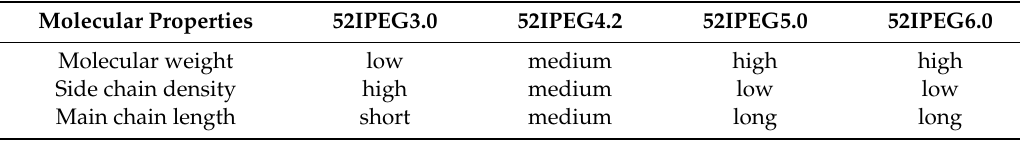
Table 3. Comparison of molecular structures of 52IPEGs.